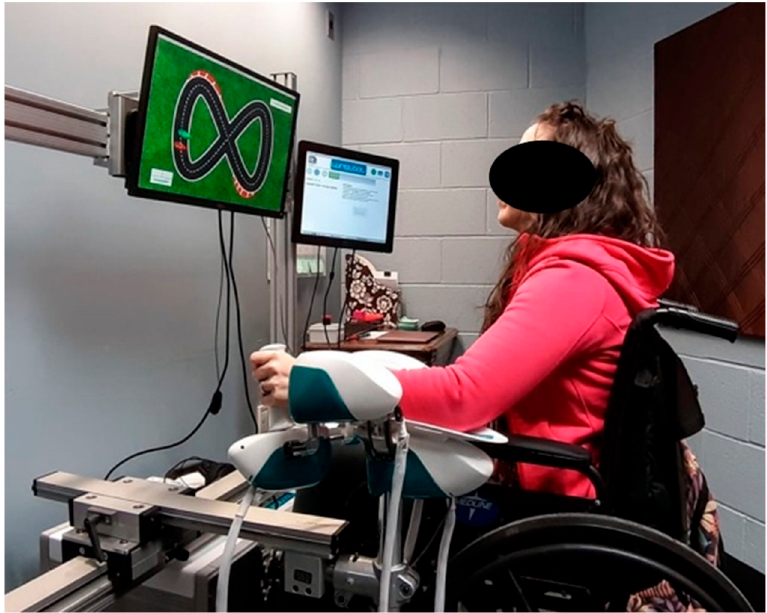
Figure 1. Experimental set-up with participant positioned at the WristBot, grasping its handle to perform the tracking task with visual